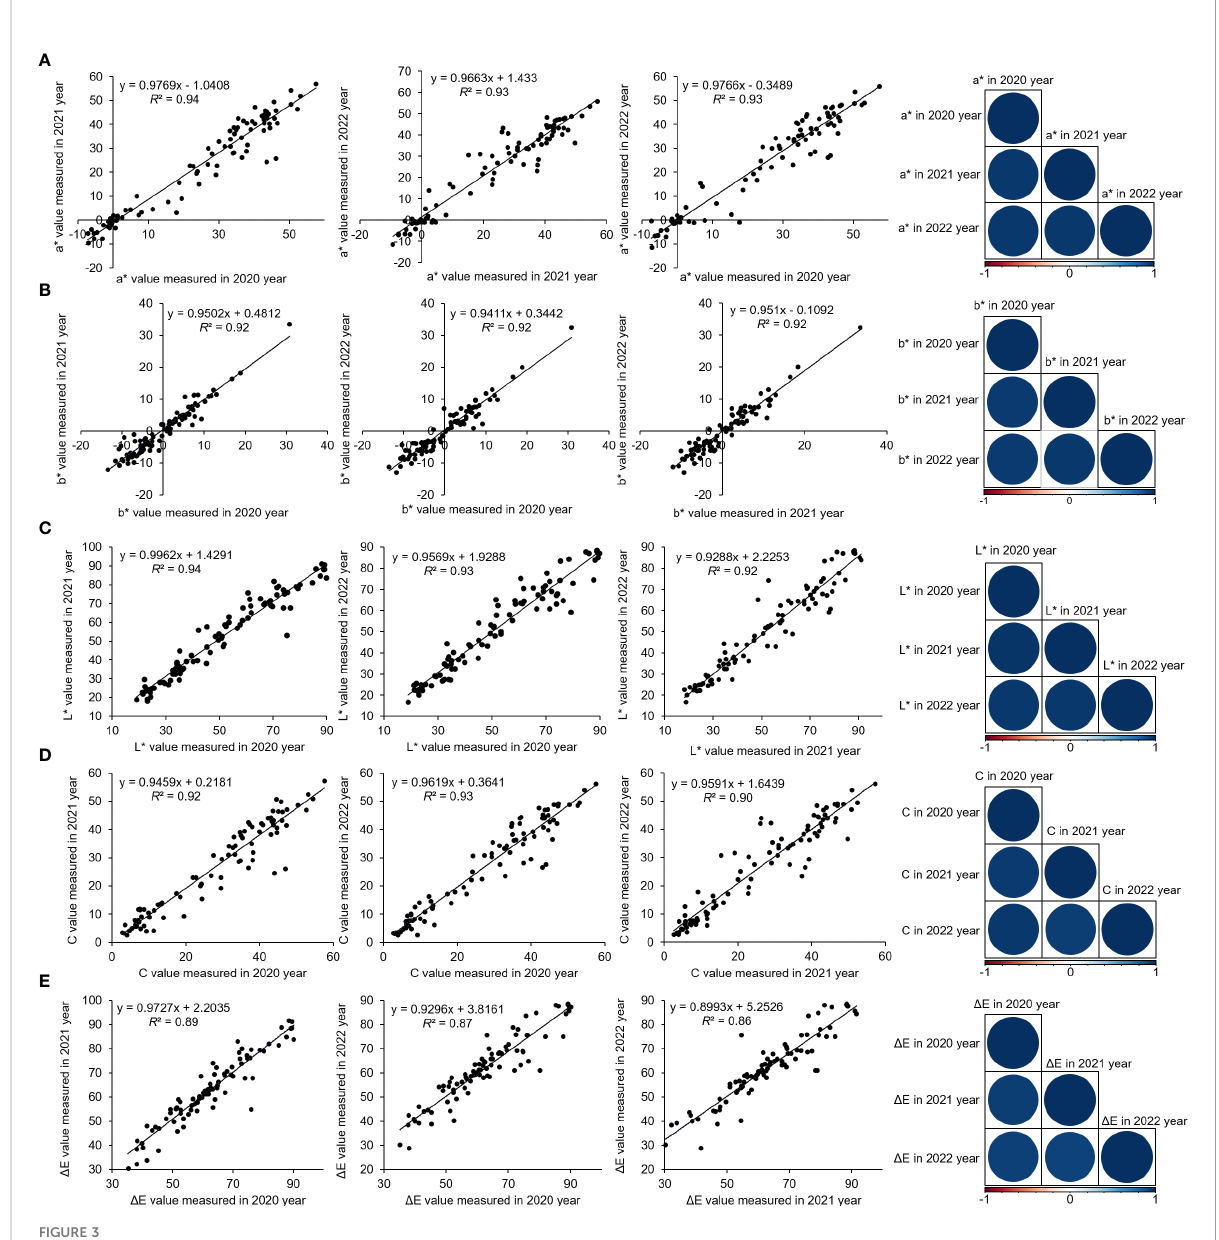
FIGURE 3 Correlation between fl ower color parameters of 99 P. lacti fl ora accessions over the three years (2020, 2021, and 2022). Linear regression analysis of a* (A) , b* (B) , L* (C) , C (D) , and D E (E) . R programming is used for data